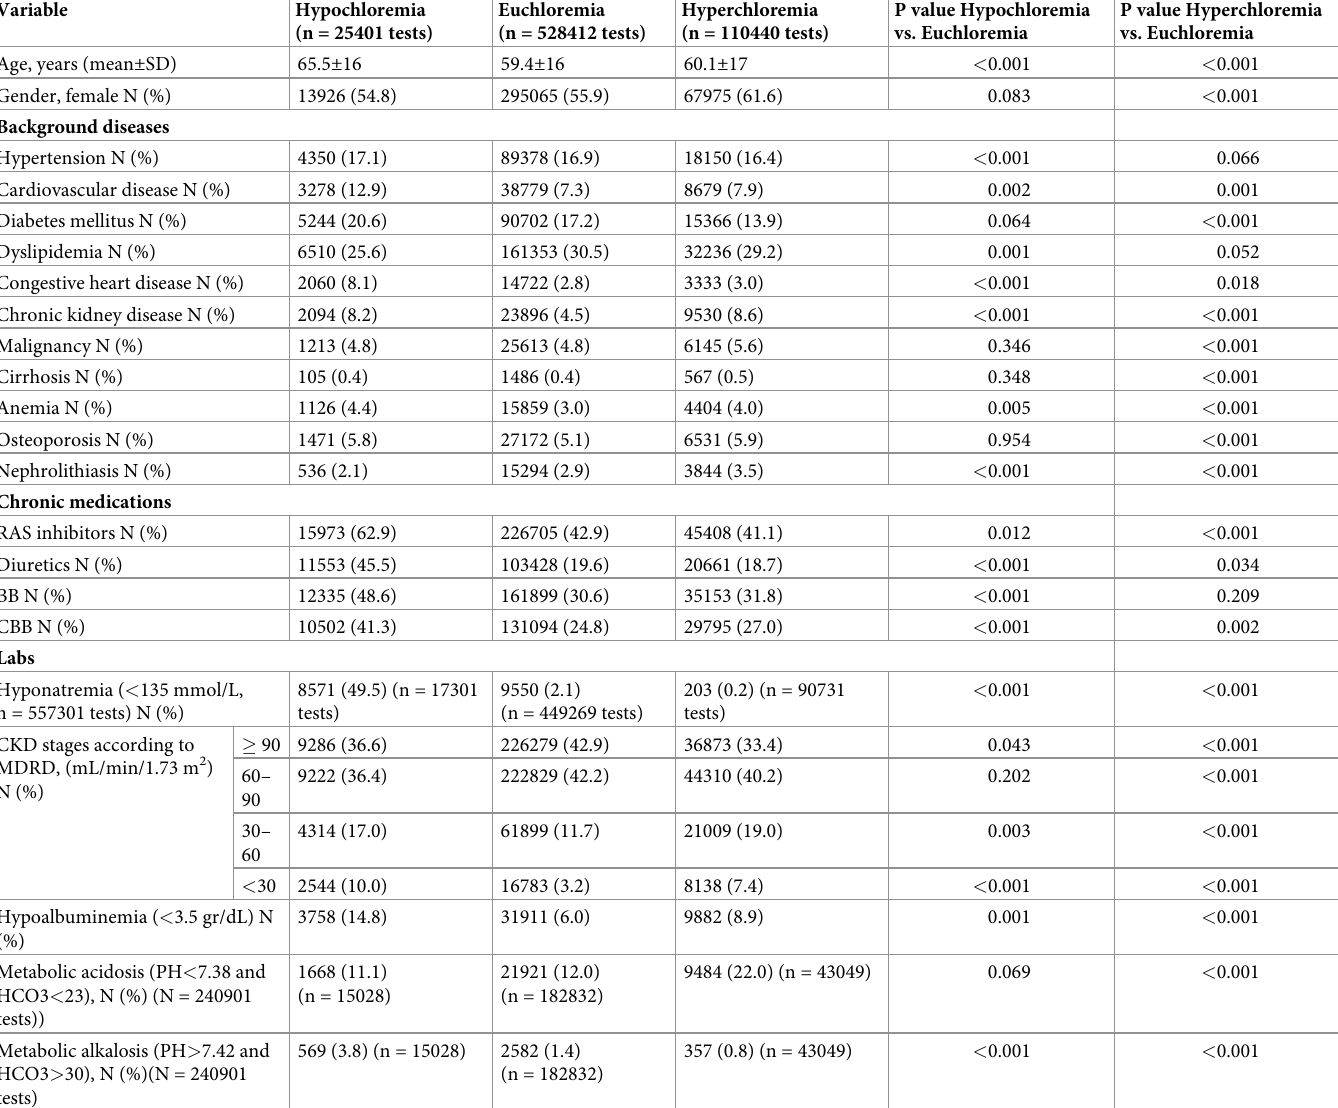
Table 1. Baseline characteristics of study population stratified per serum chloride levels: Hypochloremia ( < = 97 mmol/L), Euchloremia (98–106 mmol/L), Hyper- chloremia ( > = 107 mmol/L) (n = 664253 serum chloride tests of 105655 patients, adjusted to same patients